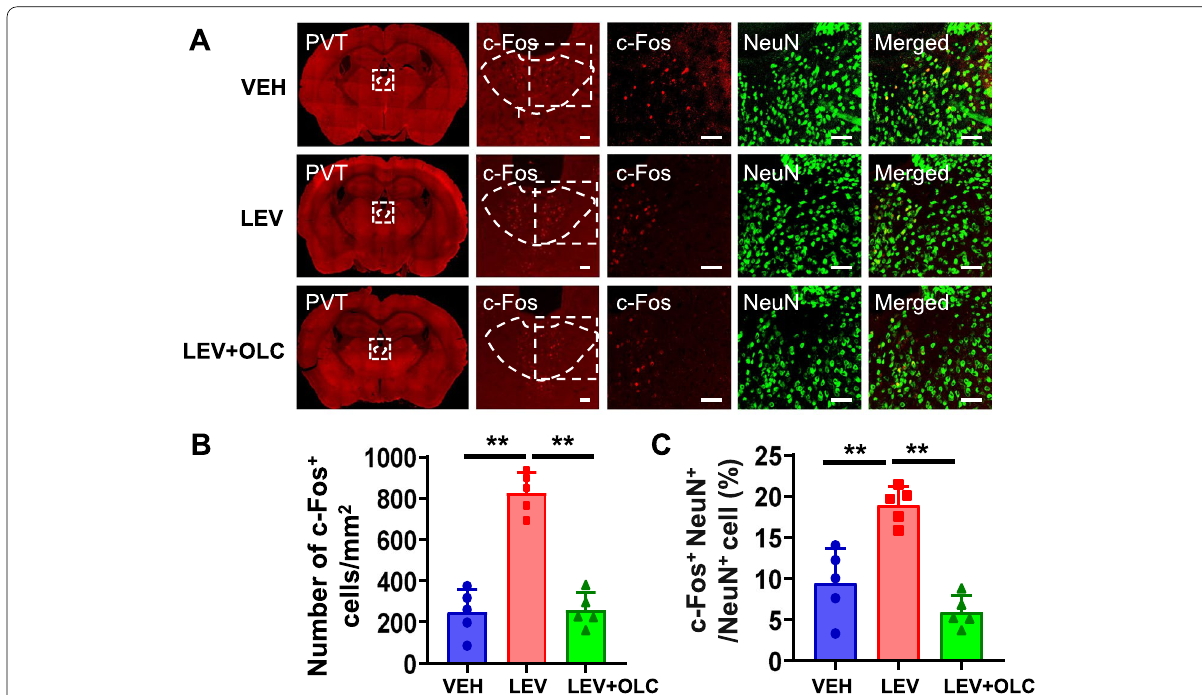
Fig. 7 c-Fos activation map of thalamic structure in the LEV-induced chronic migraine model . A. Representative pictures of c-Fos (red) and NeuN (green) immunofluorescence labeling in the PVT. Scale bars 50 μm. B‑C . PVT showed a significant increase of c-Fos + cell density ( B ) and the = percentage of c-Fos + cells in NeuN + cells ( C ), alleviated by OLC. n 5/group. One-way ANOVA with the Tukey post hoc tests, * P < 0.05, ** P < 0.01. = Abbreviations: PVT, paraventricular thalamic nucleus; OLC, olcegepant. LEV, levcromakalim